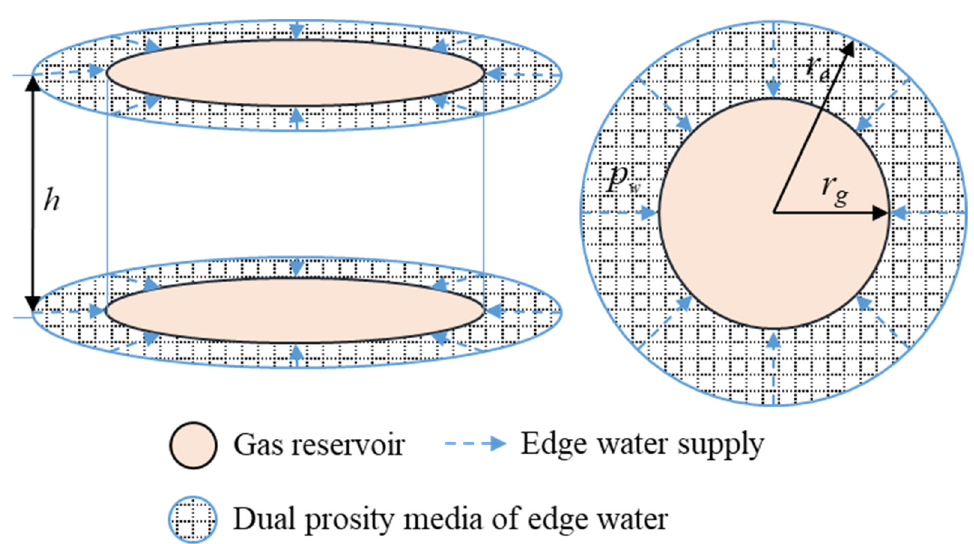
Figure 1. Naturally fractured edgewater gas reservoir. The dual porosity media of edge water is described by the Warren and Root model [30].